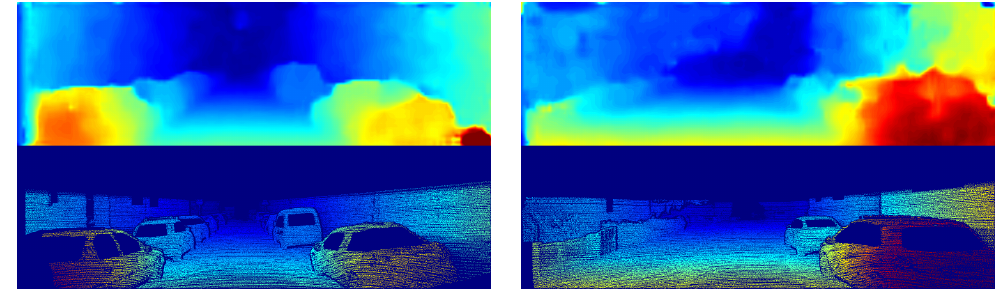
Figure 4. Examples of stereo disparity estimation using the proposed model (ground truths are depicted at the bottom of each image). ( left ) Disparity estimation over image pair 172 of the Kitti 2012 dataset [17]. ( right ) Disparity estimation over image pair 166 of the Kitti 2012 dataset [17] (in this case some artifacts appear in the estimated disparity